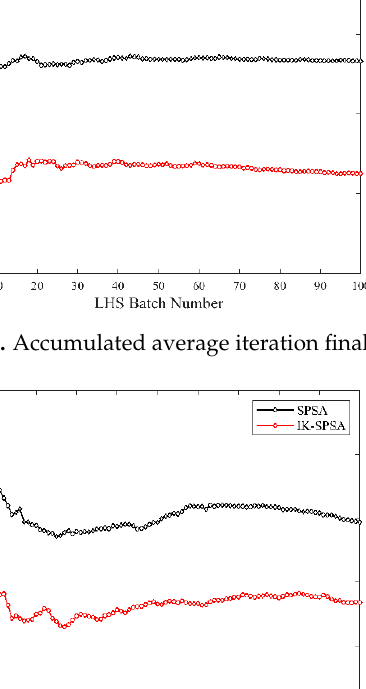
Figure 23. Accumulated average iteration final value distribution at same initial point.